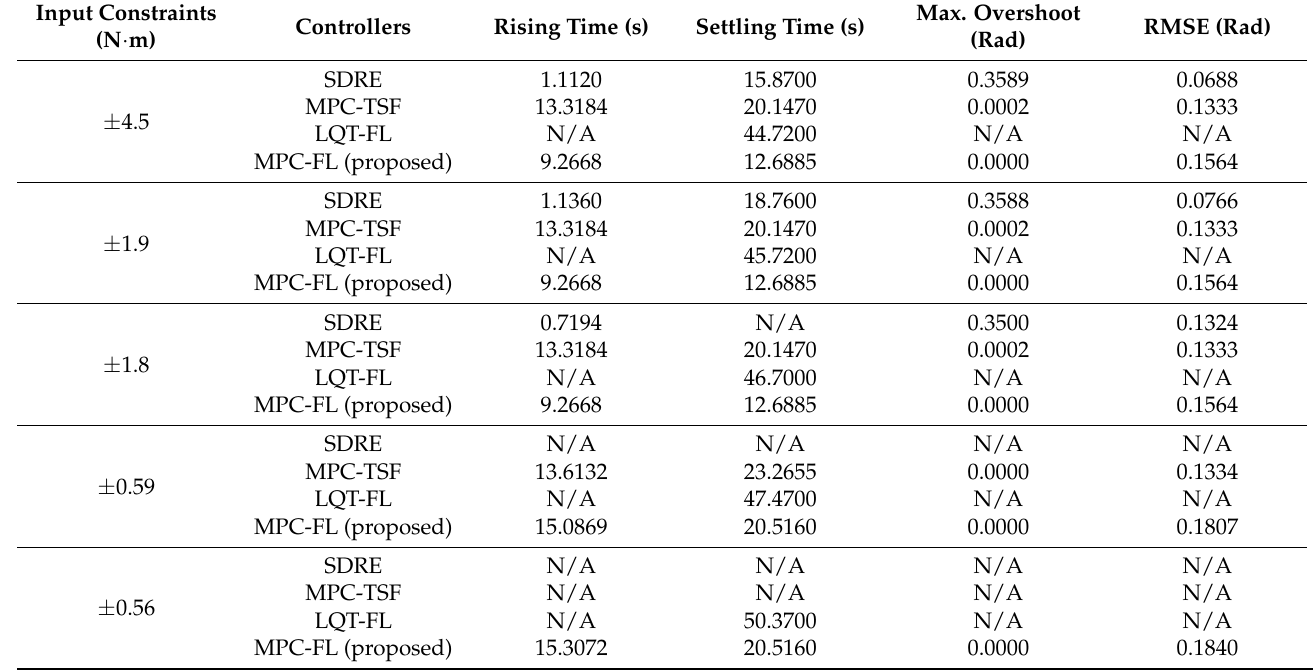
Table 4. Comparisons of control performances by applying the four control schemes with input constraints to the flexible-joint